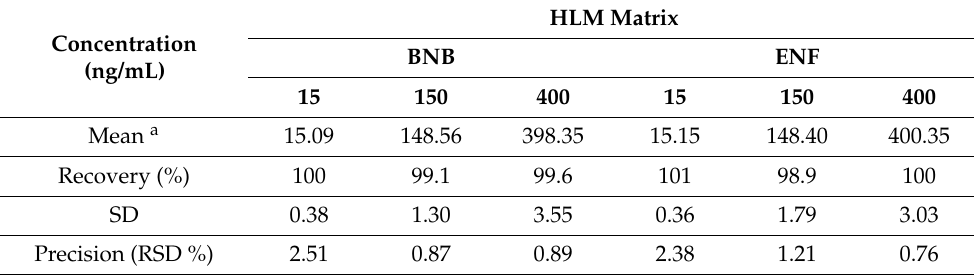
Table 3. Recovery of QC samples in the HLM